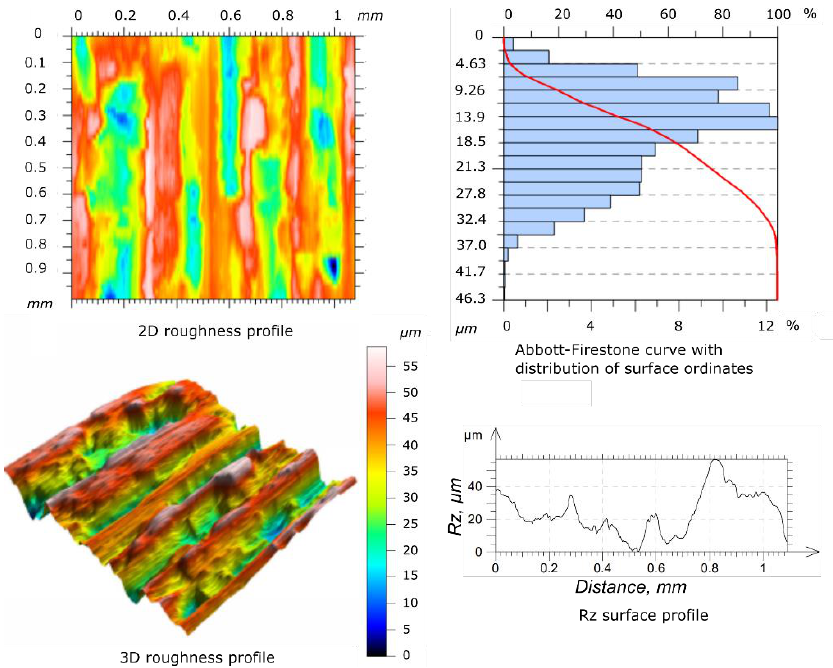
Figure 9. Geometric structure of the surface after the wear tests for specimen (conditions of test: F = 0.1 N, α = 10°, f = 5 Hz).